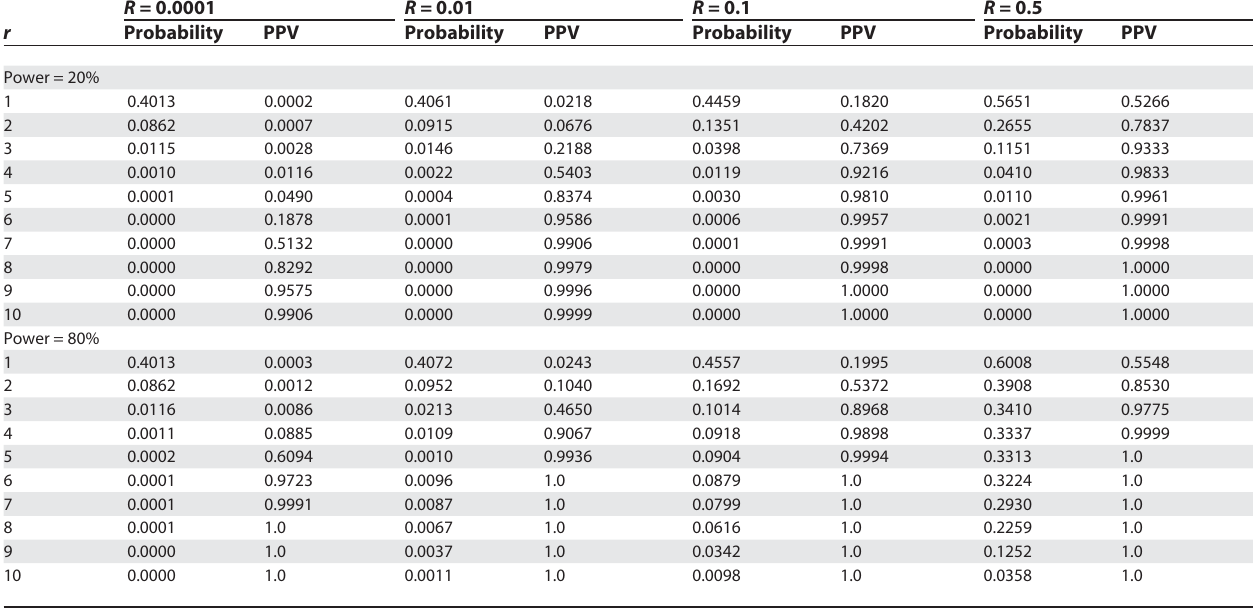
Table 2. Probability of Obtaining At Least r Signifi cant Results Out of Ten Studies when Pre-Study Odds Equal 0.0001, 0.01, 0.1, and 0.5 R = 0.0001 R = 0.01 R = 0.1 R = 0.5 r Probability